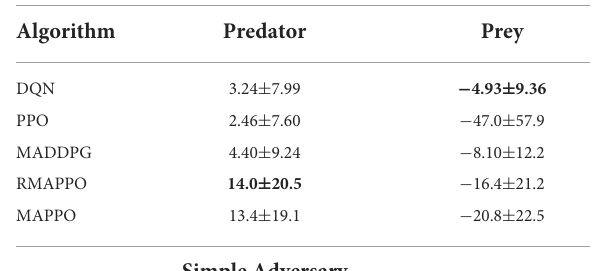
TABLE 1 Final scores (mean and standard deviation) of algorithms obtained over the last 100 episodes across all 5 seeds in the Space Invaders and Simple Reference environments.